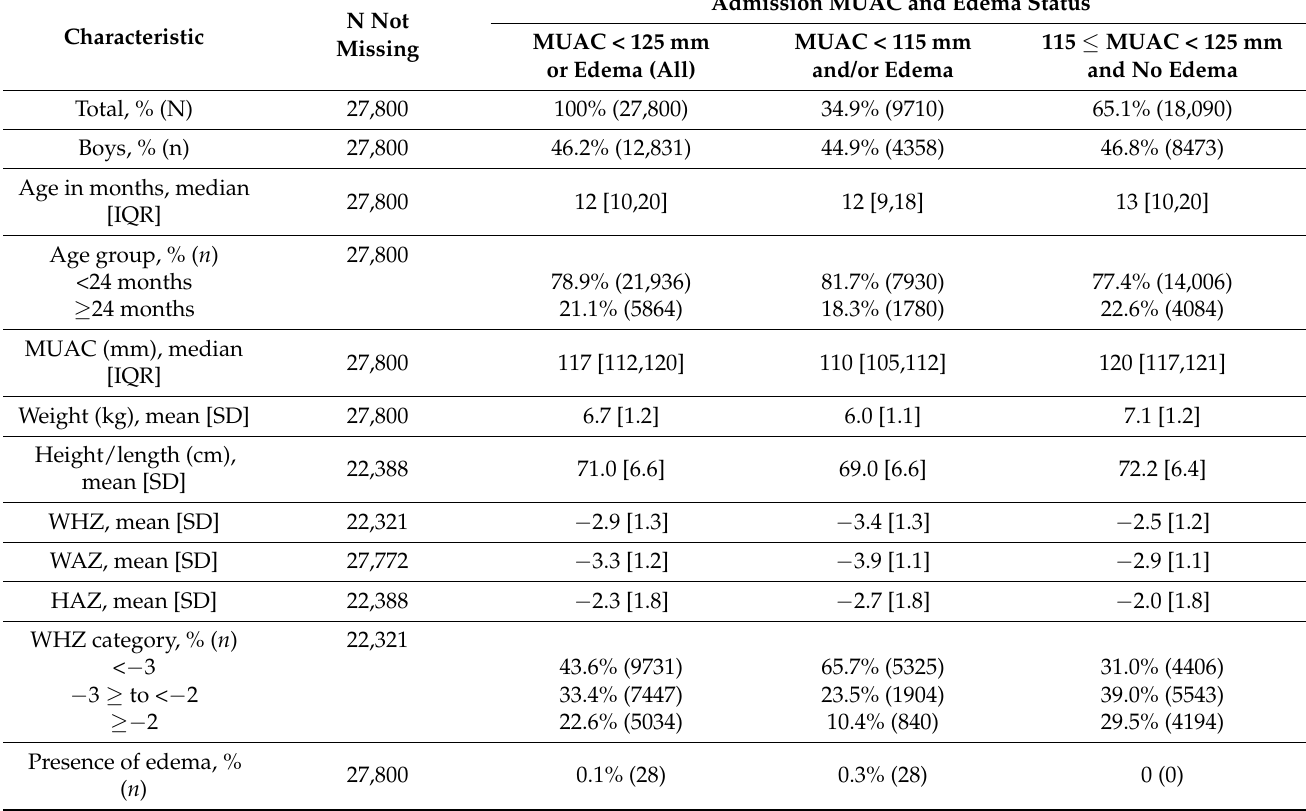
Table 1. Baseline characteristics of children admitted to treatment according to simplified, combined